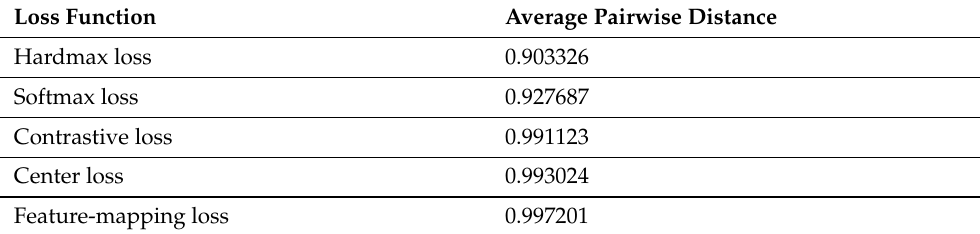
Table 3. Average pairwise distances between the centers (row vectors of the last fc layer). This distance indicates how sparsely these centers are distributed. The more discriminative the representations, the larger the average pairwise distance.